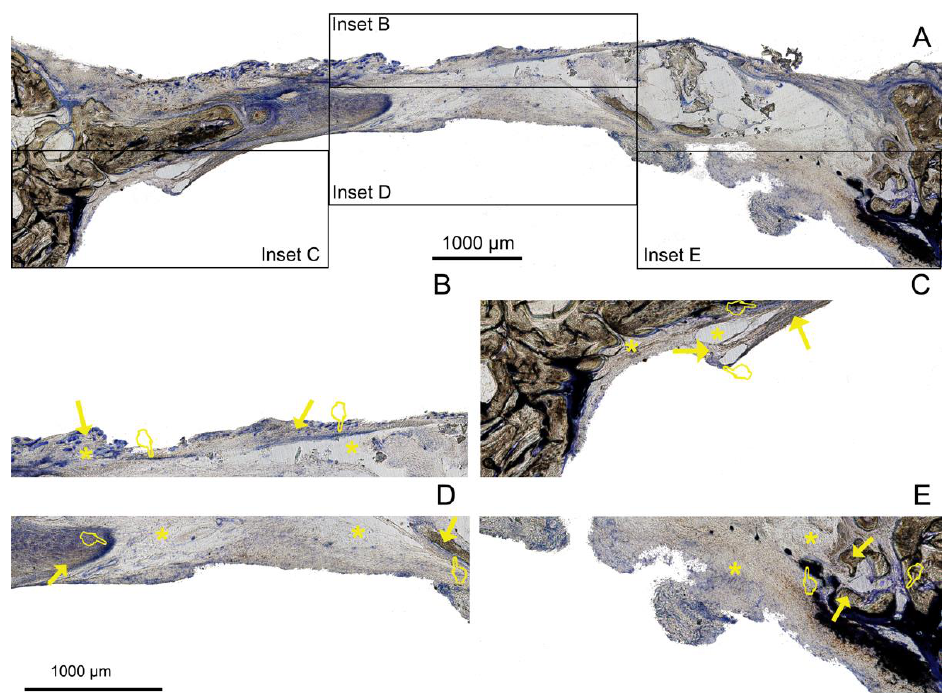
is indicated by asterisks. ( A ) General view. Insets AB, AC, AD, and AE reflect the corresponding areas analyzed in Figure 5B – E; ( B ) indicates a partial view of R1 area (top left); ( C ) R3 (top right); ( D ) R5 (bottom central); and ( E ) R6 (bottom right). ( B , C ) show zones with the lowest NBAs observed (R1). ( D ) permits the observation of soft tissue that was present in higher proportion when com- pared with the rest of the groups after using this doxycycline-doped membrane. ( E ) shows a rela- tively low proportion of STA and a high proportion of NBA in comparison with the rest of the re- gions within this group of analysis.